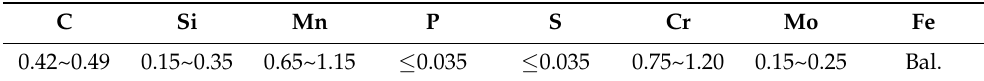
Table 1. Chemical composition of the applied 4145H steel in this work.